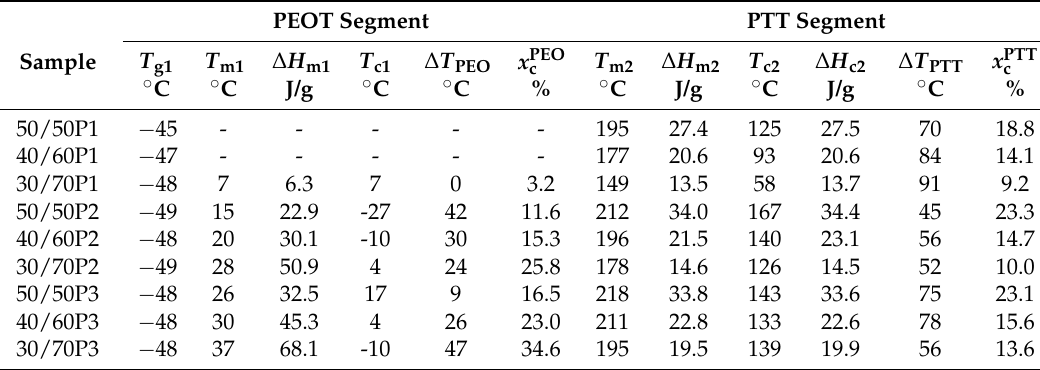
Table 2. Thermal properties of PTT- block -PEOT